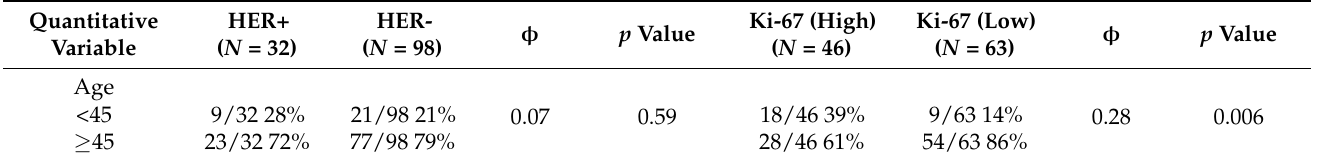
Table 3. Relation between CEM and HER and Ki67